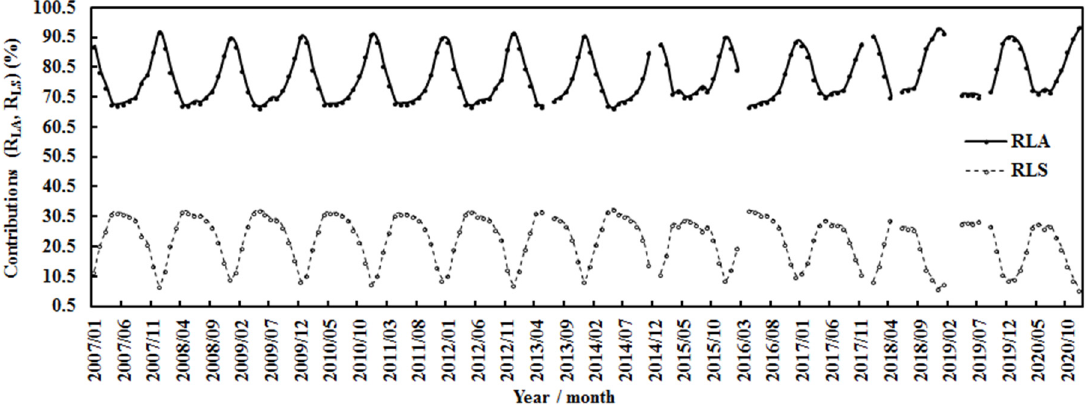
Figure 10. Contributions (R LA and R LS ) of monthly absorbing and scattering losses to the monthly total loss at the Qomolangma